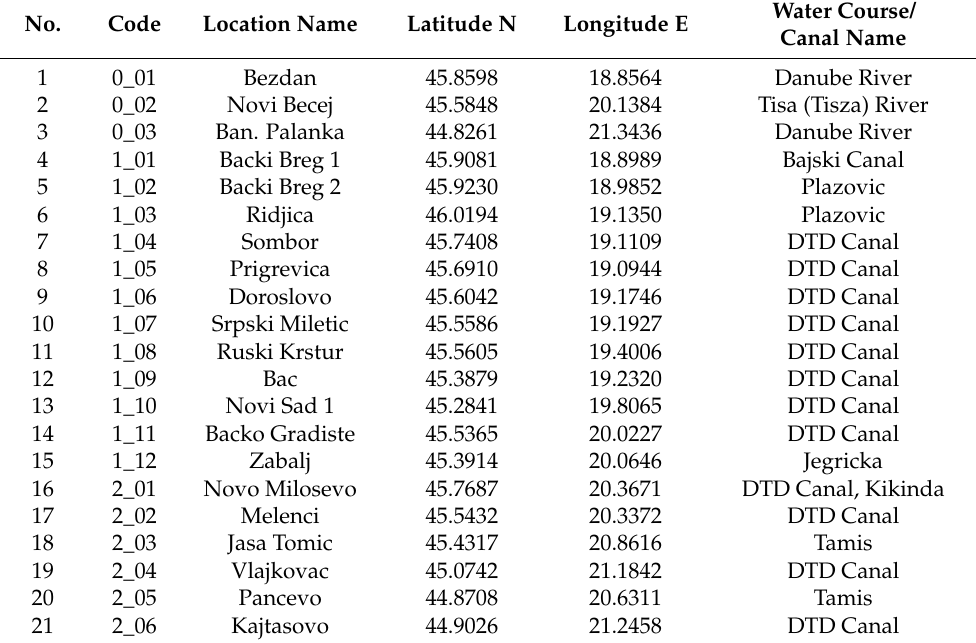
Table 1. Codes and coordinates of examined water-quality monitoring stations. No.